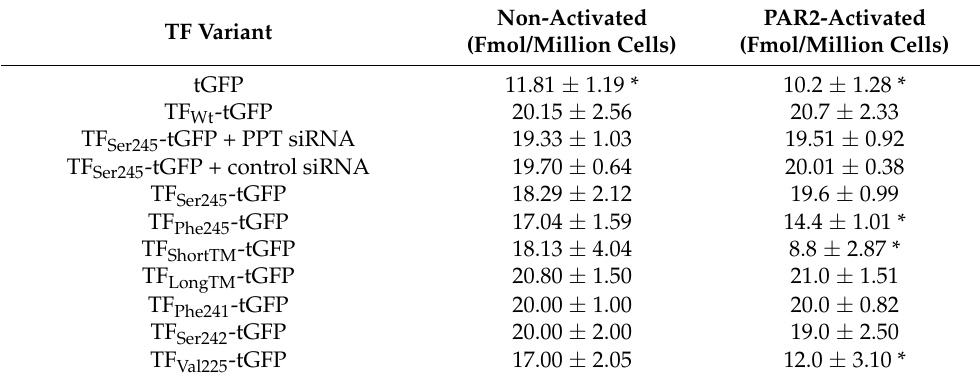
Table 2. Analysis of the interaction of fVIIa-HRP with TF-tGFP variants expressed on the cell